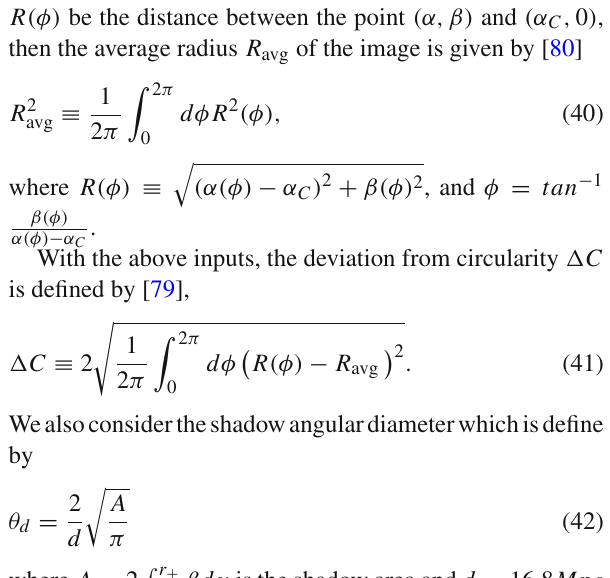
Fig. 17 The plot at upper left position represents the variation of angle of deflection ˆ α p with p / M for different values of b with = 0 . 5 and l = 0 . 2. The plot at upper right posi- F = 4 π e 2 N 0 r 0 m ω 2 ∞ tion describes the variation of ˆ α p with p / M for different values